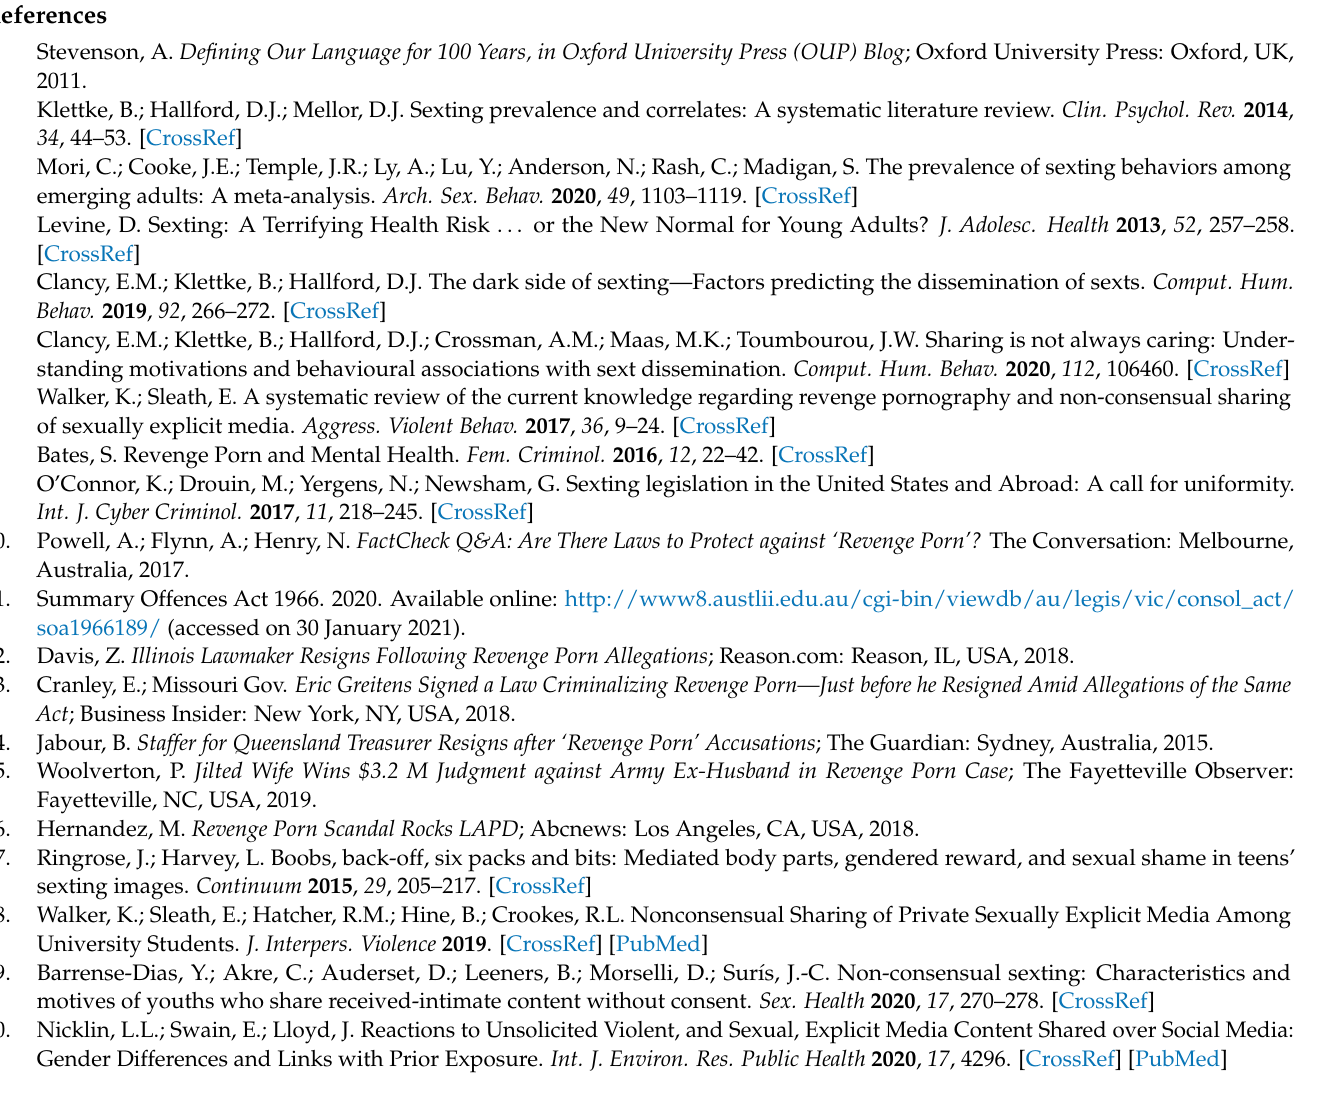
Scale Mean Scale Variance Corrected Squared Cronbach’s if Item if Item Item-Total Multiple Alpha if Item Deleted Deleted Correlation Correlation